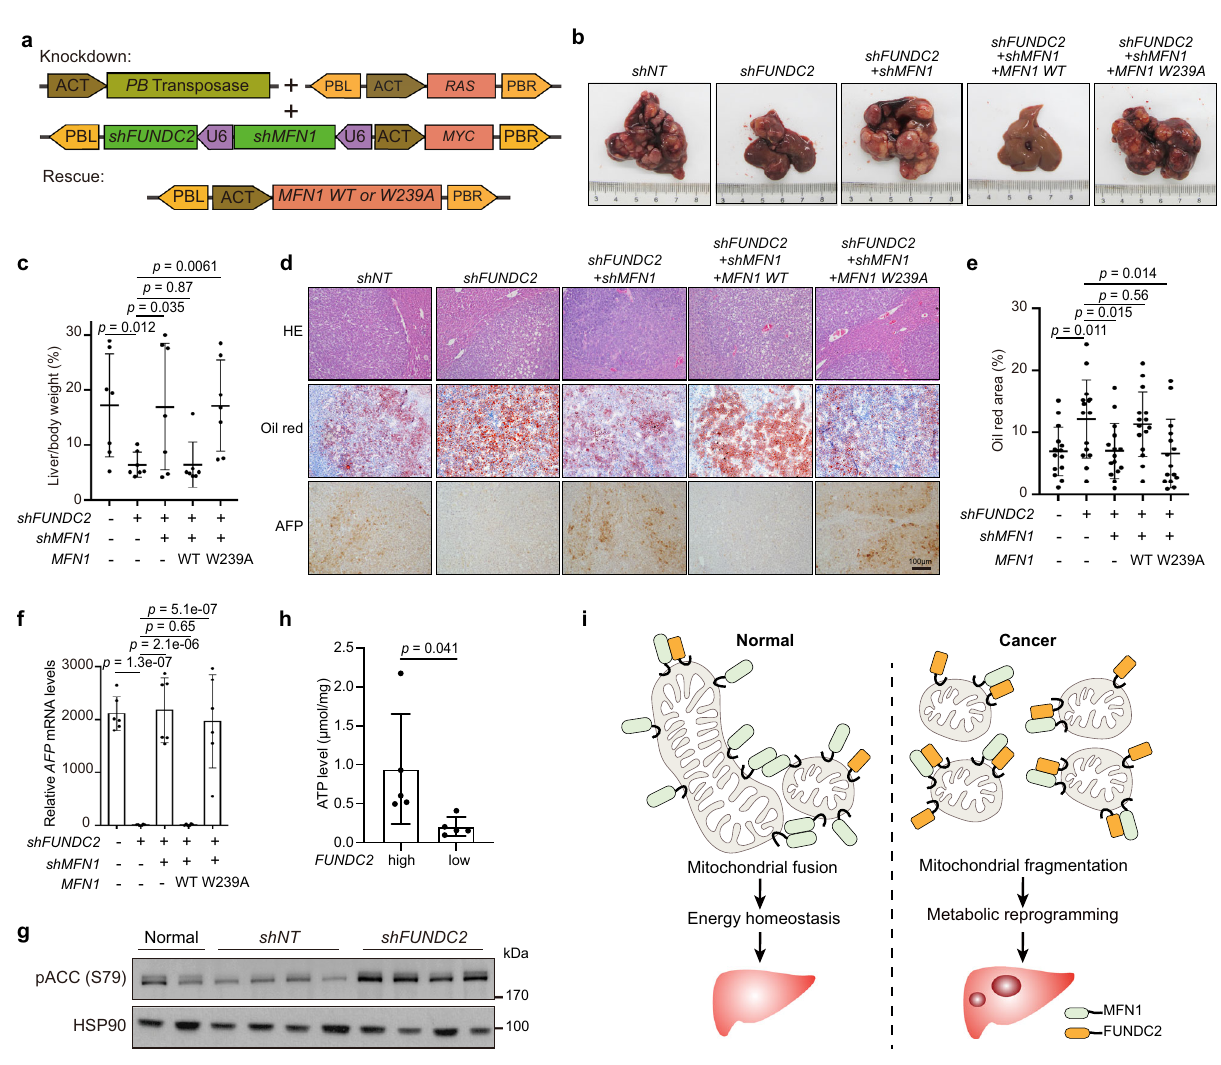
Fig. 8 FUNDC2 promotes tumorigenesis through inhibiting MFN1. a Illustration of plasmids used for multiplexed genome editing in vivo. b Knockdown of MFN1 in addition to FUNDC2 rescued tumorigenesis. Representative livers at 80 days after injection were shown. c Liver/body weight ratio was quanti fi ed, n = 7. d Histopathological analysis of tumors in c . Liver sections were stained by HE, oil red, and IHC with speci fi c antibodies. e Quanti fi cation of oil red staining from 5 sections for each group in d . f Determination of AFP mRNA levels by quantitative RT-PCR, n = 6. g Knockdown of FUNDC2 induced ACC phosphorylation in MYC + RAS tumors. Tumor lysates were examined by western blotting. h Human HCC with higher expression of FUNDC2 have higher energy level. FUNDC2 high and low tumor samples were lysed and ATP levels were measured, n = 5. i A model depicting elevated FUNDC2 in HCC promotes tumorigenesis by inhibiting MFN1-mediated mitochondrial fusion. n was biological replicates for all experiments. Data are presented as mean ± SD. p values were calculated by two-tailed unpaired Student ’ s t -test. Source data are provided as a Source data fi